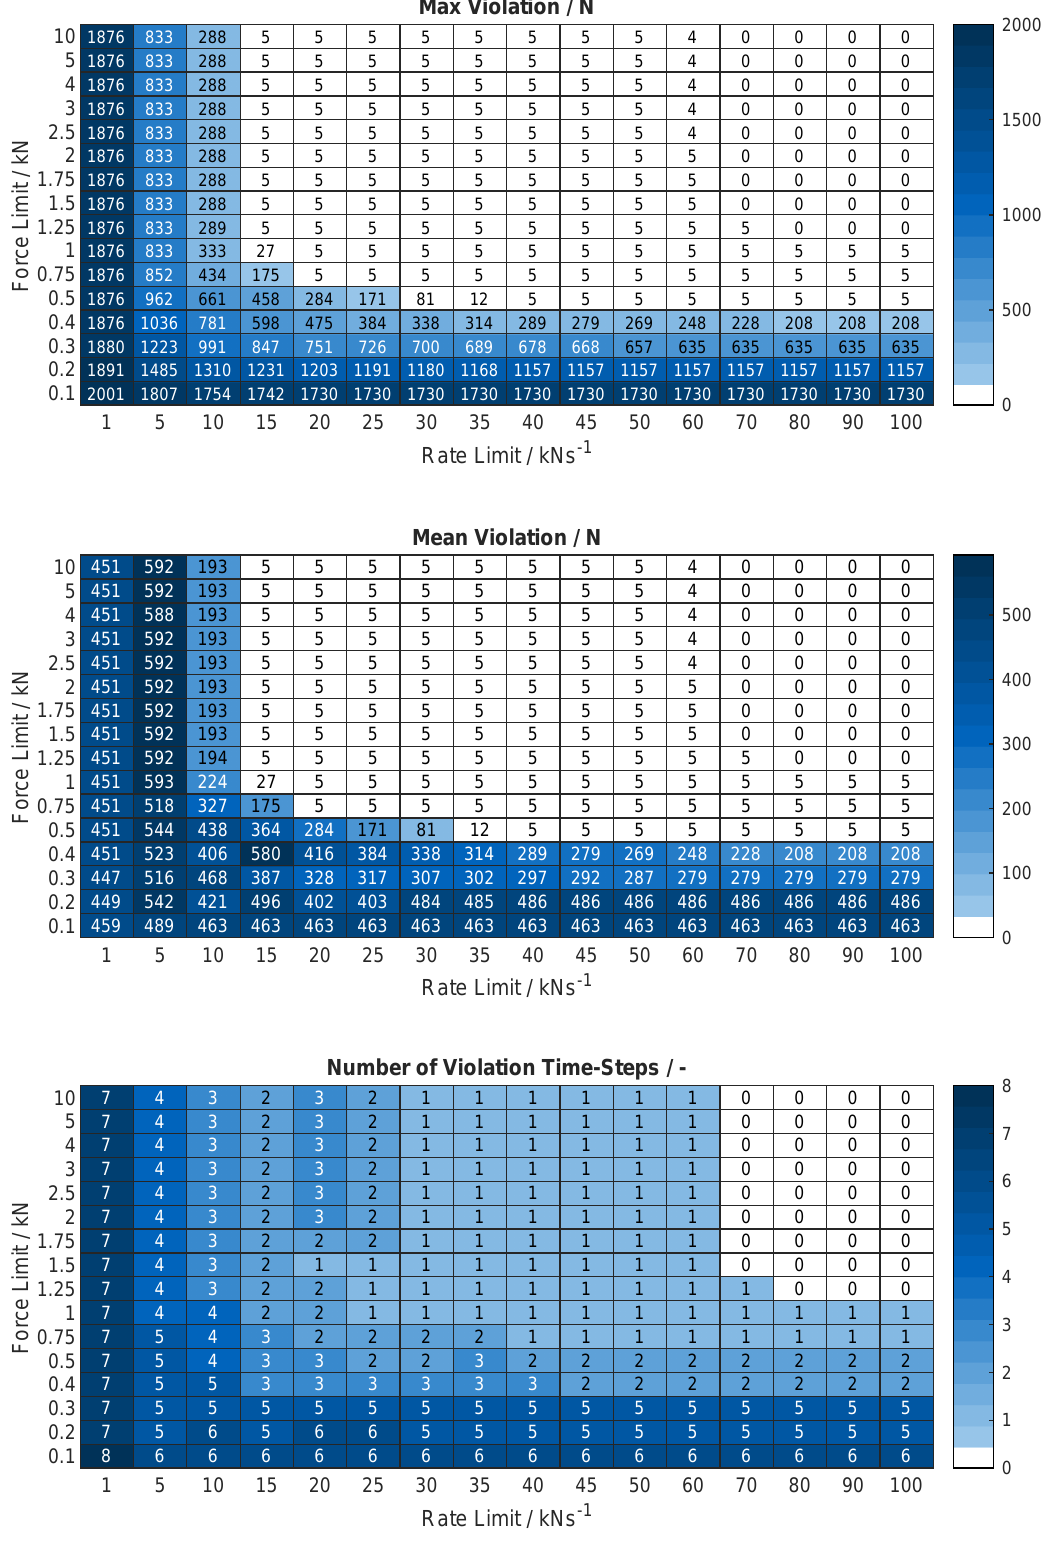
Figure A19. Dynamic wheel-load constraint violations in the 90kmh − 1 BC profile dynamic wheel-load optimization